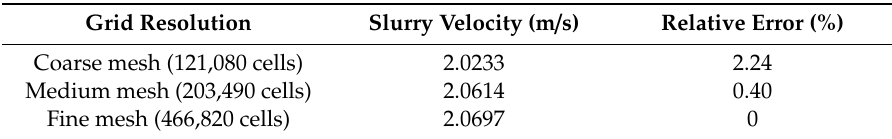
Figure 2. Contours of the slurry velocity under different gird cells for the numerical simulation of sand transport and deposition in multiphase flow pipelines. Table 2. Slurry velocity at the central point of the cross-section of 20 times the pipe diameter under different gird cells for the numerical simulation of sand transport and deposition in multiphase flow pipelines.